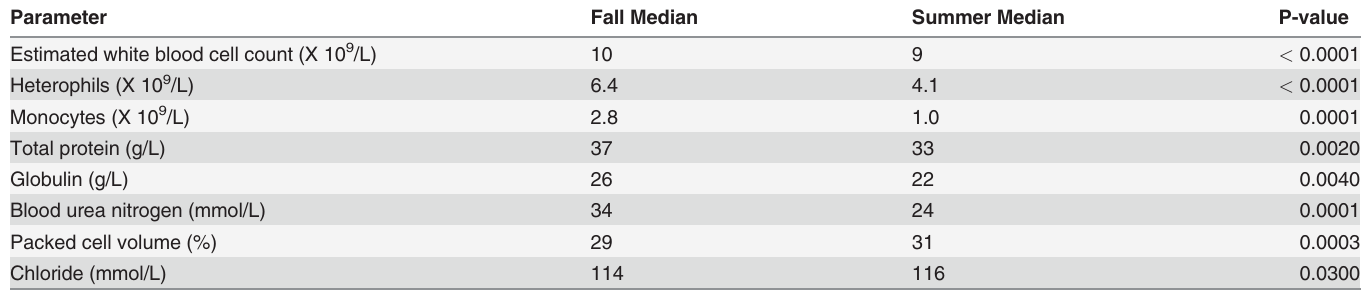
Table 2. Hematology and plasma biochemical parameters that exhibited signi fi cant variation between the fall (October and November) and summer (May through September) sampling periods in juvenile loggerhead sea turtles ( Caretta caretta ) sampled in Core Sound, North Carolina,